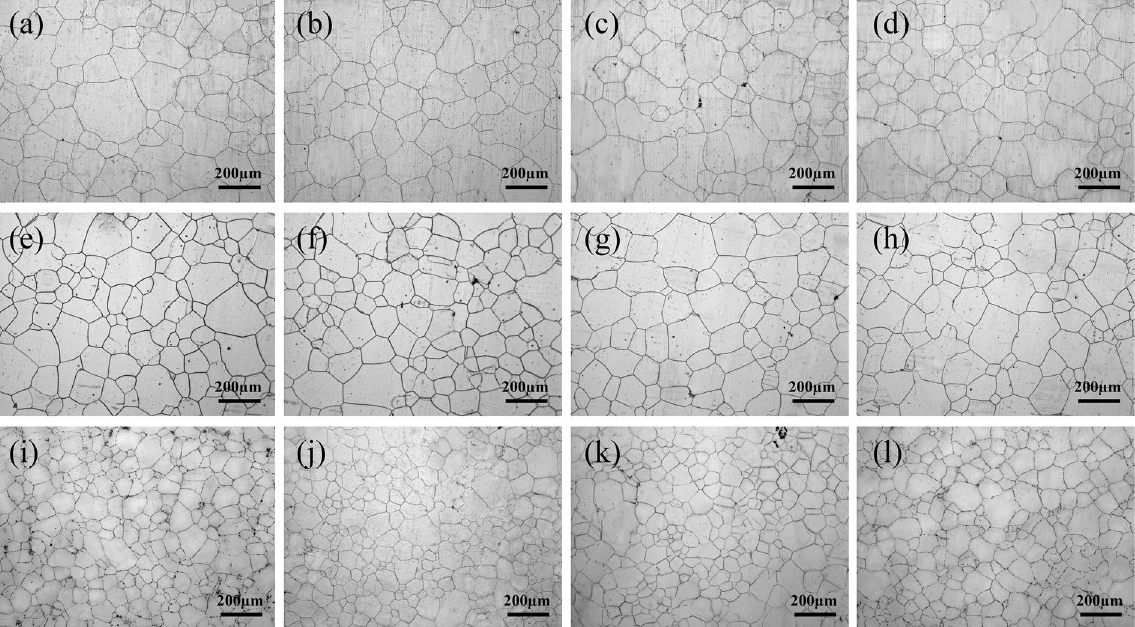
Figure 4. Optical microscopy images of Mg-5Sn alloy microstructures: ( a ) unrolled and subjected to solution treatment at 480 °C for 24 h, ( b ) further aged at 170 °C for 10 h, ( c ) 35 h, and ( d ) 60 h; ( e ) as-rolled (20%) and subjected to solution treatment at 480 °C for 24 h, ( f ) further aged at 170 °C for 10 h, ( g ) 35 h, and ( h ) 60 h; and ( i ) as-rolled (50%) and subjected to solution treatment at 480 °C for 24 h, ( j ) further aged at 170 °C for 10 h, ( k ) 35 h, and ( l ) 60